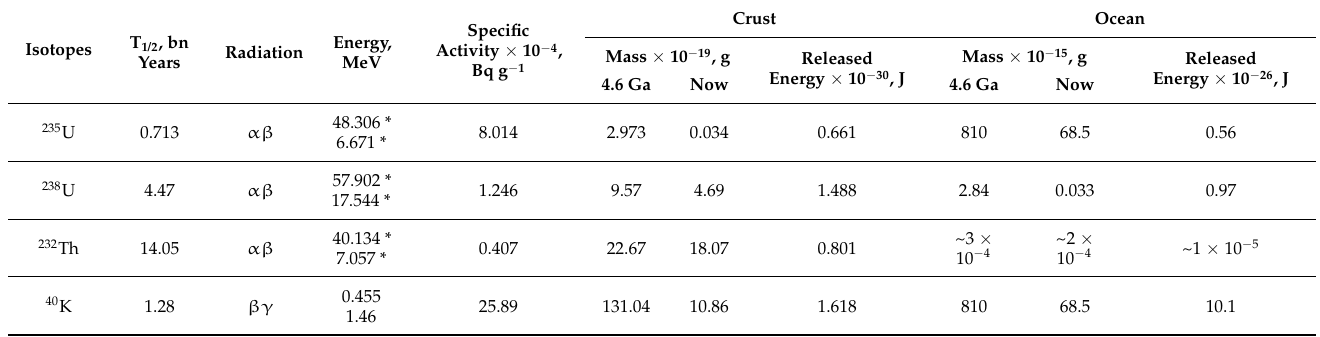
Table 1. Long-lived natural radioactive elements in the earth’s crust and ocean and their